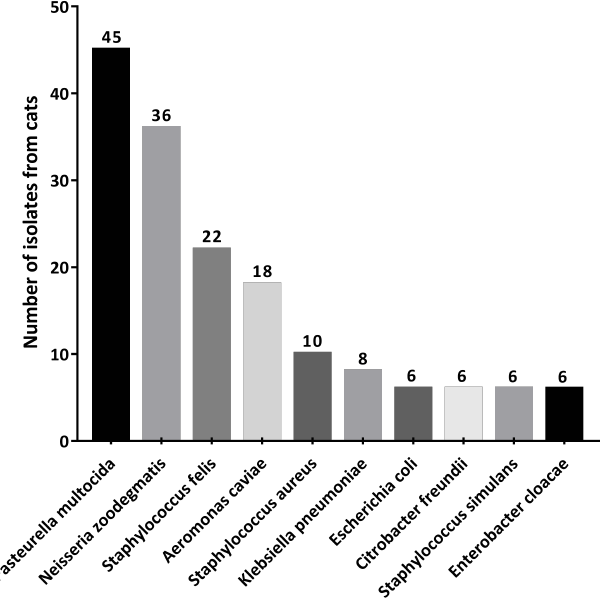
Figure 1. The top 10 strains from the 242 isolated strains from cafe cats. P. multocida had the largest percentage of the 242 isolates, followed by Neisseria zoodegmatis and Staphylococcus felis